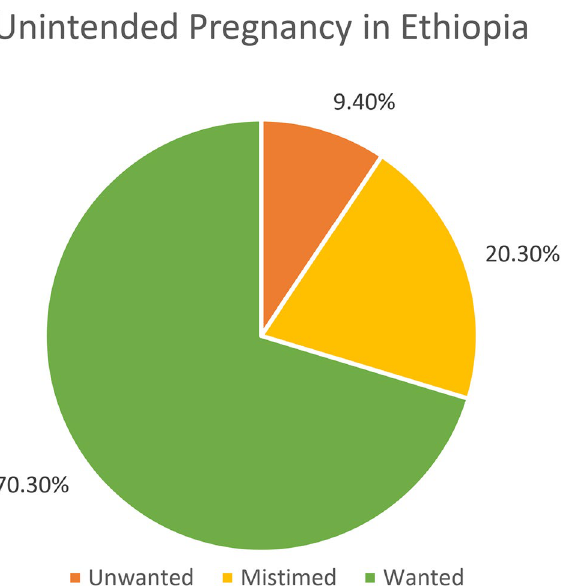
Figure 2. The prevalence of unintended pregnancy among pregnant women in Ethiopia,